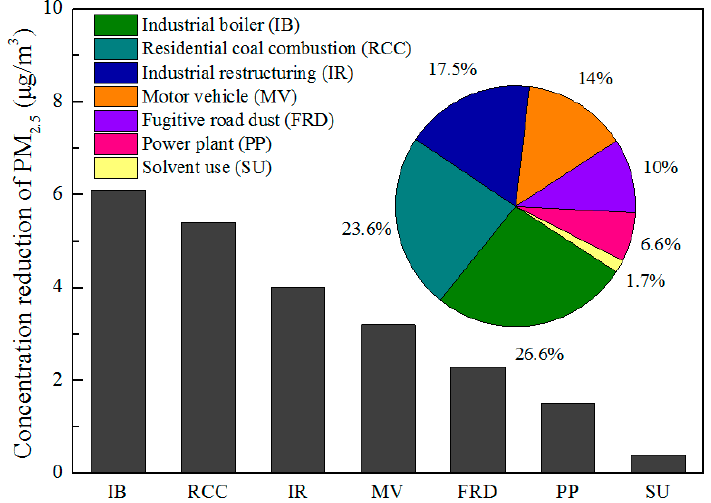
Figure 7. Contribution to reduction of PM 2.5 concentration by control measures in 2017 compared with 2013.